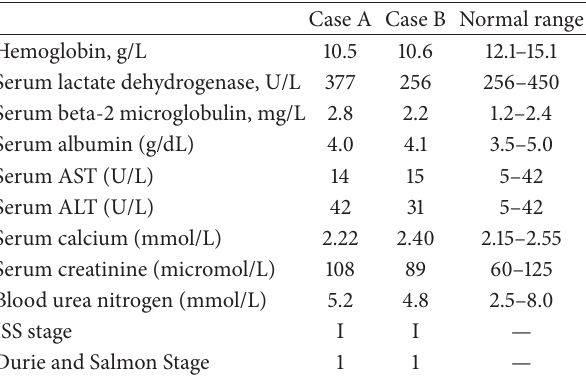
Table 1: Clinical variables at diagnosis of patients A and